Question: Write a single sentence explaining what this figure depicts.
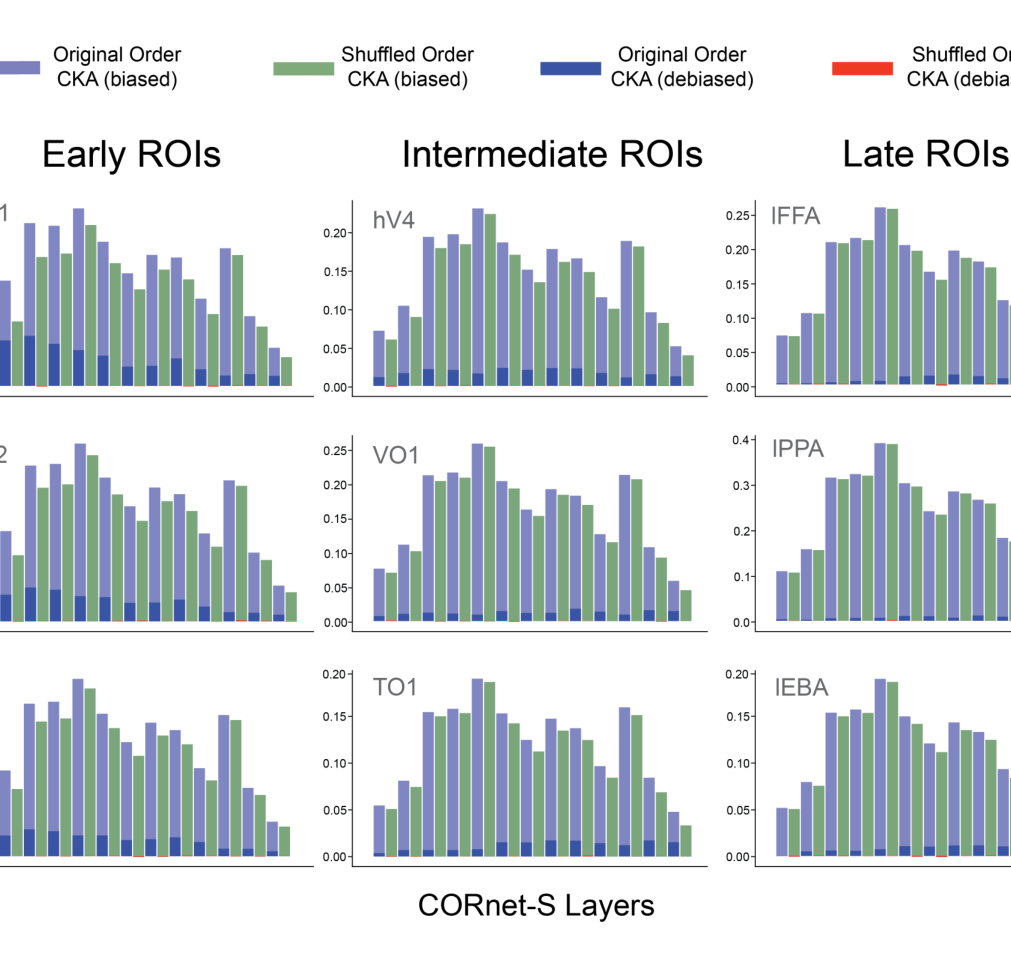
Answer: Across early (V1, V2, V3), intermediate (hV4, VO1, TO1) and late (left-FFA, left-PPA, left-EBA) ROIs, biased CKA is contrasted with debiased CKA across the original data order and the mean of five shuffled versions across three fMRI participants over CORnet-S. Debiased CKA is the only metric that shows sensitivity to stimuli-driven responses and with it we replicate the previously-reported pattern that lower visual areas exhibit greater correspondence to lower-layer CNN representations and similarly for higher visual areas / higher-layer CNNs.